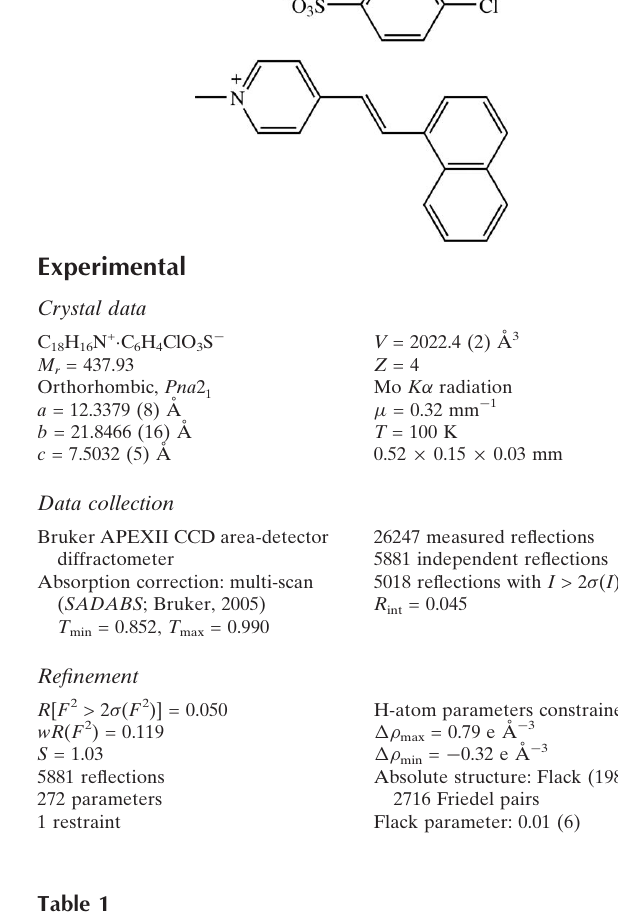
Hydrogen-bond geometry (A˚ , (cid:4)